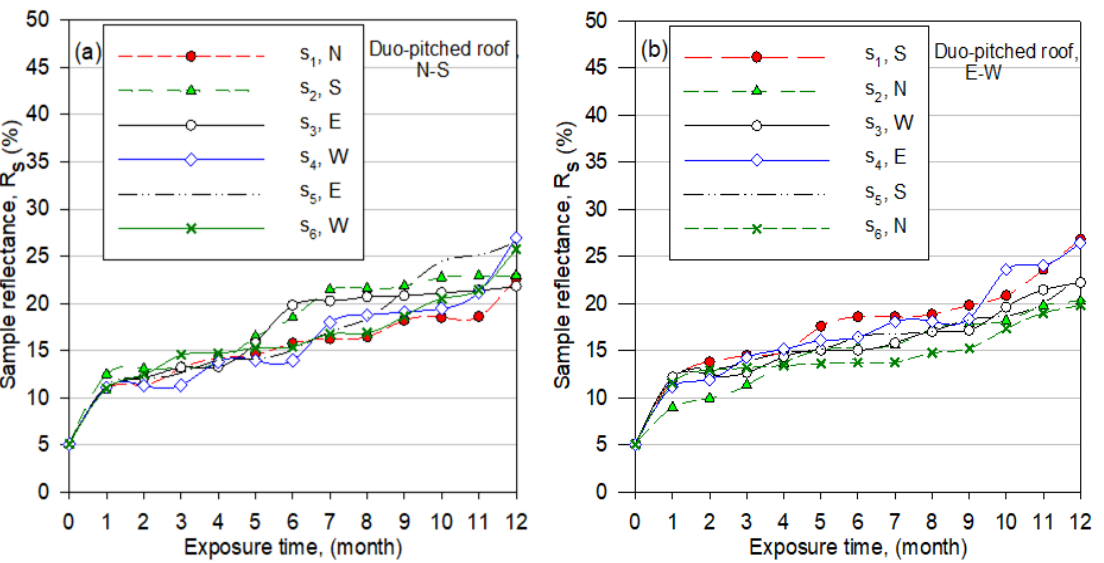
Figure 6. Variation of the sample reflectances ( R s ) affected by the exposure time for the duo-pitched roof prototype cover oriented in the N–S ( a ) and E–W ( b ) directions under arid climatic conditions.